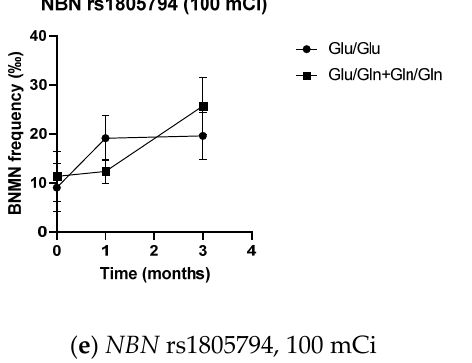
Figure 4. BNMN frequency (‰, mean ± S.D.) in DTC patients before and after (1, 3/6, and 24 months) therapy with 131 I, according to genotype and 131 I dose group: ( a ) MLH1 rs1799977, 70 mCi; ( b ) MLH1 rs1799977, 100 mCi; ( c ) MSH3 rs26279, 100 mCi; ( d ) MSH4 rs5745325, 100 mCi; ( e ) NBN rs1805794, 100 mCi.